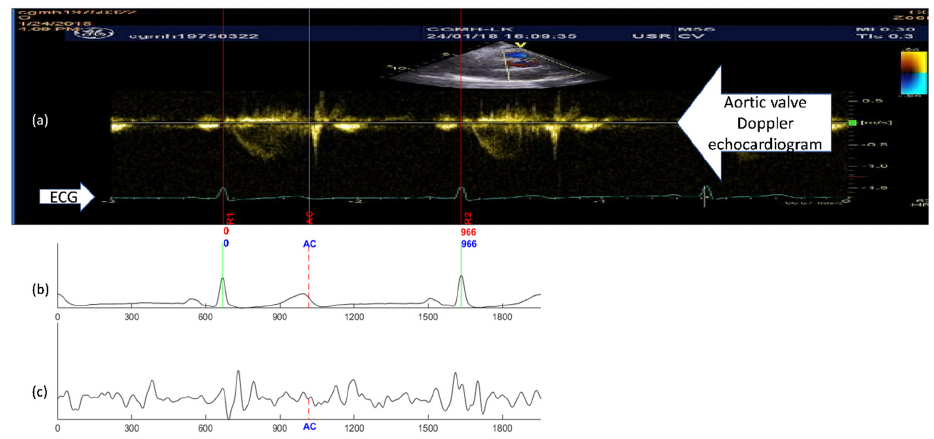
Figure 5. Illustration of aligning a reference signal pair to the selected echocardiogram section and projecting the specific cardiac event (aortic valve closing, AC) from echocardiogram to SCG curve as the detected fiducial point: ( a ) Echocardiogram image and the selected section enclosed within vertical lines marked with R1 and R2; ( b ) The aligned ECG of the reference signal pair; ( c ) The aligned SCG of the reference signal pair.